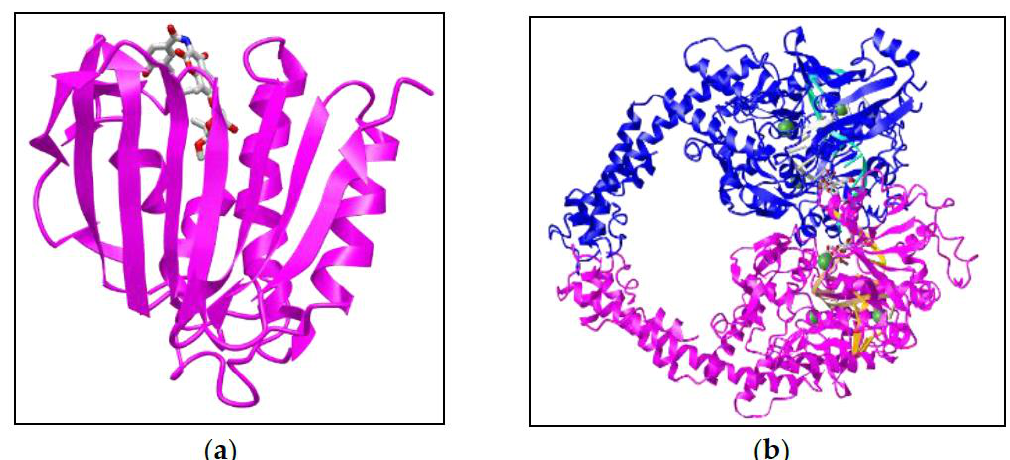
Figure 2. The XRD crystal structures of ( a ) Staph GyraseB (4URO) in complexation with novobiocin (sourced on 5th January 2021 from https://www.ncbi.nlm.nih.gov/Structure/pdb/4URO, 2.59 Å resolution), and ( b ) h -TOP-IIβ (Topoisomerase- IIβ/3QX3) in complexation with DNA-etoposide (sourced on 5th January 2021 from https://www.ncbi.nlm.nih.gov/Structure/pdb/3QX3, 2.16 Å resolution).